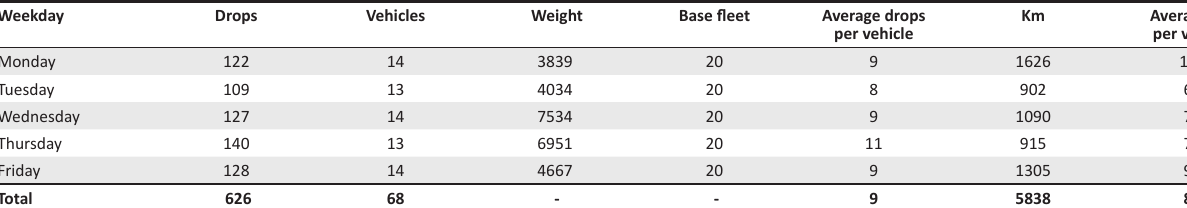
TABLE 2: Distribution centre 2 plan case study baseline.